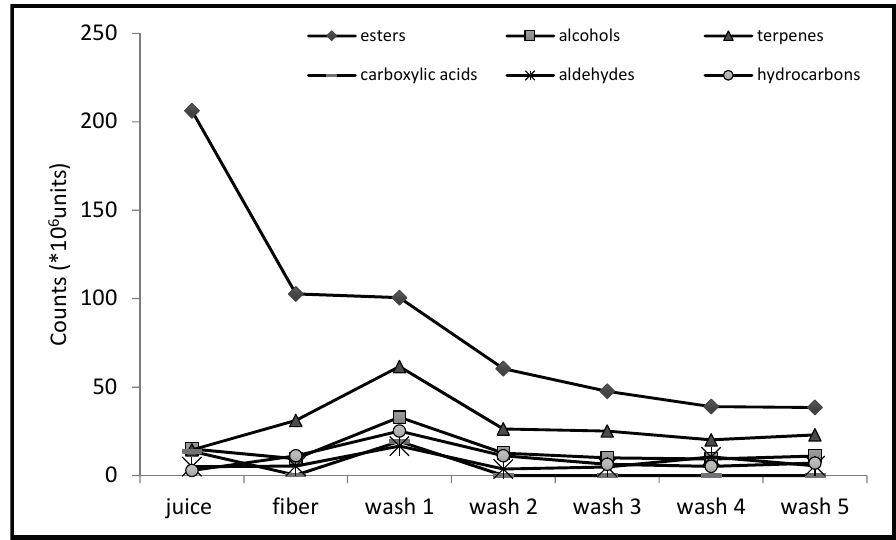
Figure 1. Chromatogram area counts, by chemical class, of headspace volatile compounds of cashew juice and